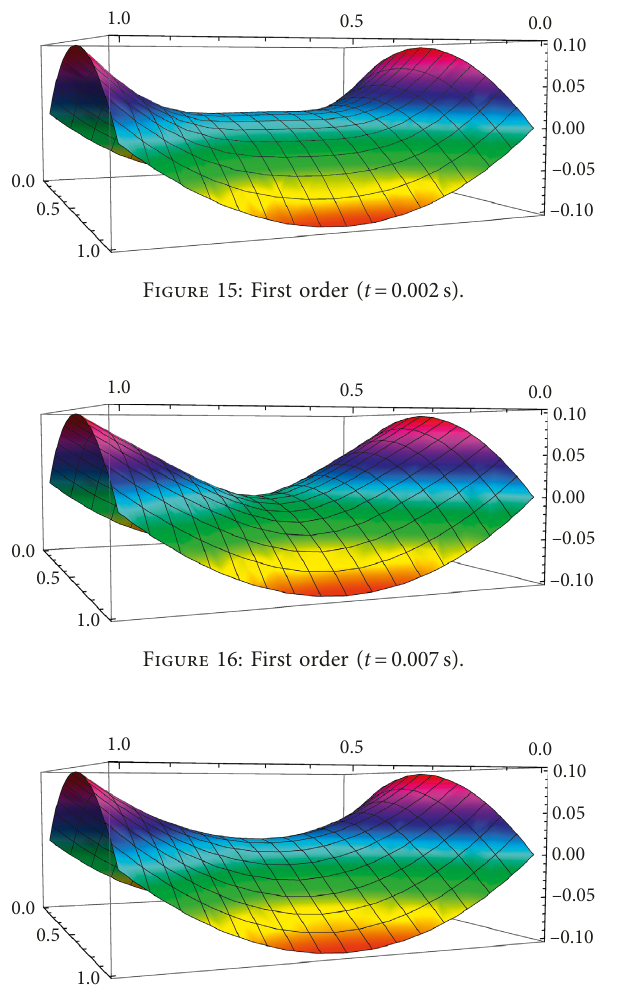
Figure 22: Superposing of the first three orders ( t � 0.007s).